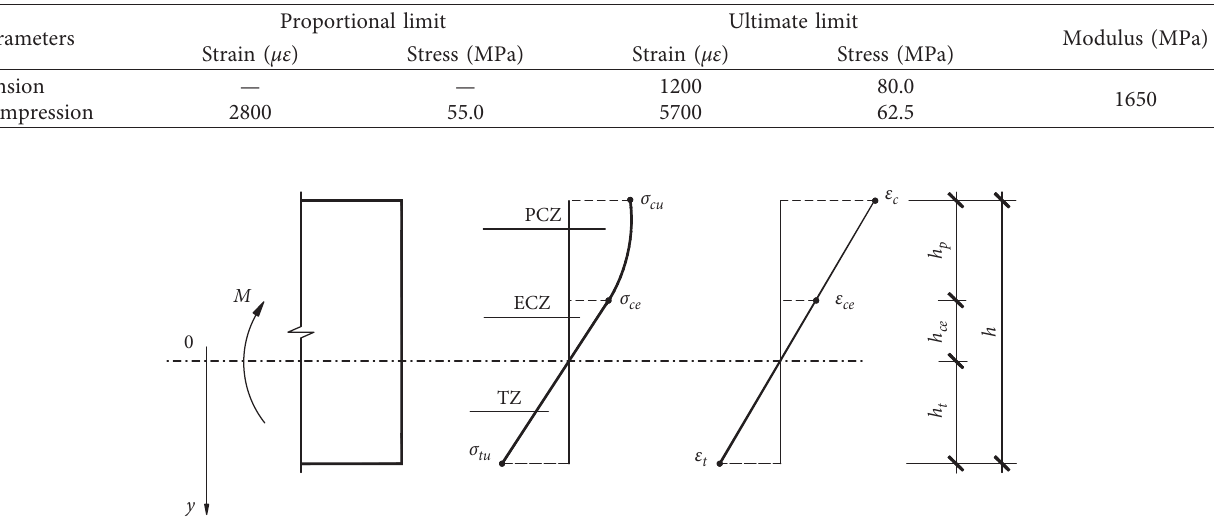
Figure 3: Diagrams of the stress and strain over the moment section. (a) stress diagram and (b) strain